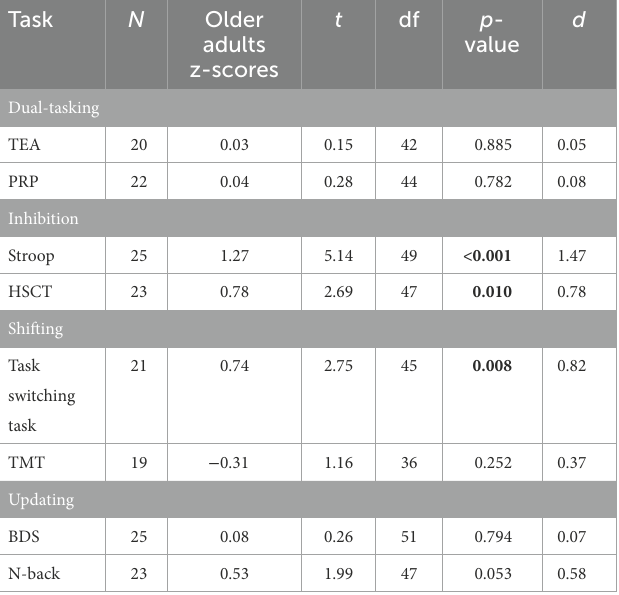
TABLE 3 Decline in executive function abilities in older adults in comparison to young adults.